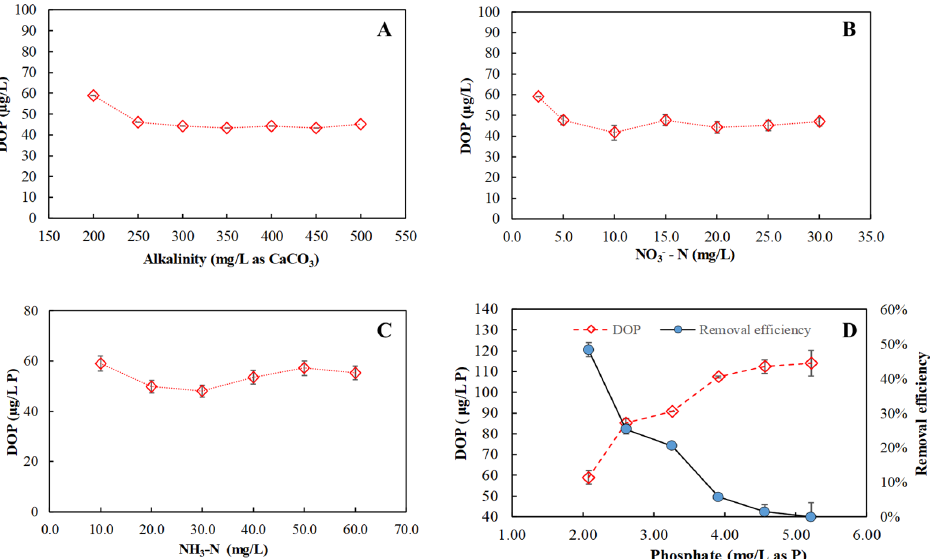
Figure 3. Effects of different wastewater matrix constituents on residual DOP during ferrate (VI) treatment of secondary effluent. (Fe (VI) dose = 5.0 mg/L; initial DOP = 114 μ g/L P; and initial pH = ment of secondary effluent. (Fe (VI) dose = 5.0 mg/L; initial DOP = 114 µ g/L P; and initial pH = 6.5) ( A ) alkalinity: 200–500 mg/L as CaCO 3 ; ( B ) NO 3 ¯-N: 2.6–30.0 mg/L; ( C ) NH 3 -N: 10.6–60 mg/L; and ( D ) phosphate: 2.08–5.22 mg/L as P.